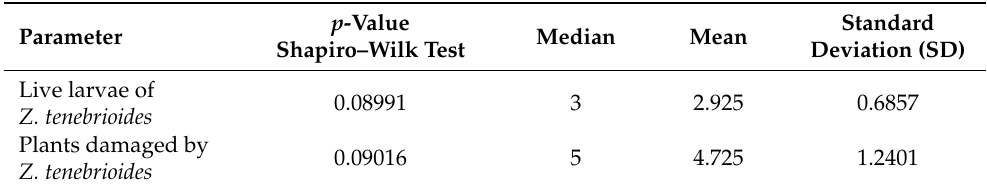
Table 1. Student’s t -test for numbers of live Z. tenebrioides larvae and damaged plants per m 2 before the application of nematodes.